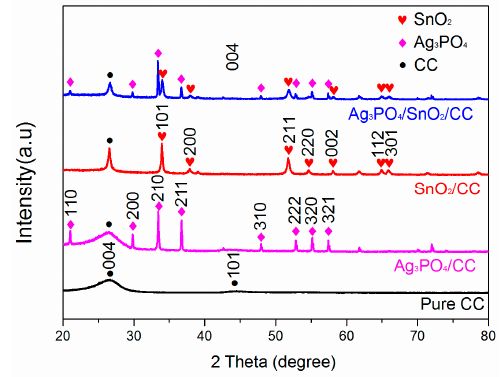
/ CC, SnO / CC and Ag 2